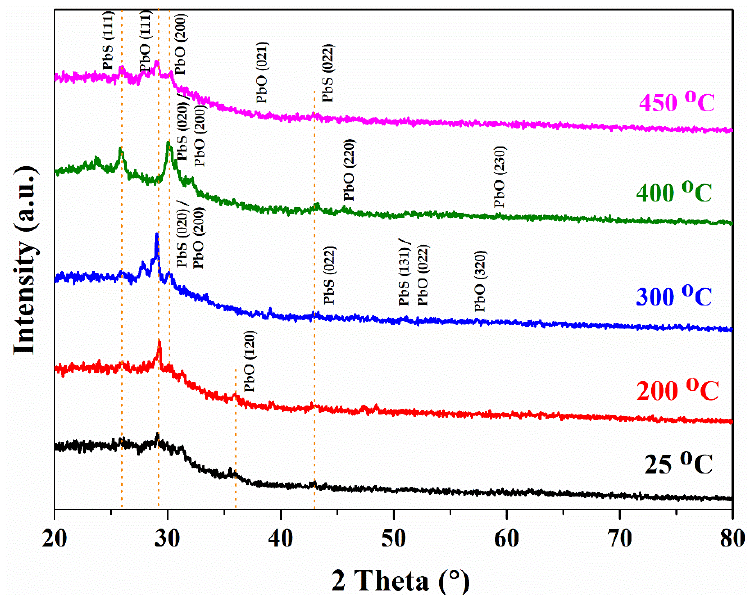
Figure 1. X-ray diffraction pattern of PbS thin film at 25 °C, 200 °C, 300 °C, 400 °C, and 450 °C.